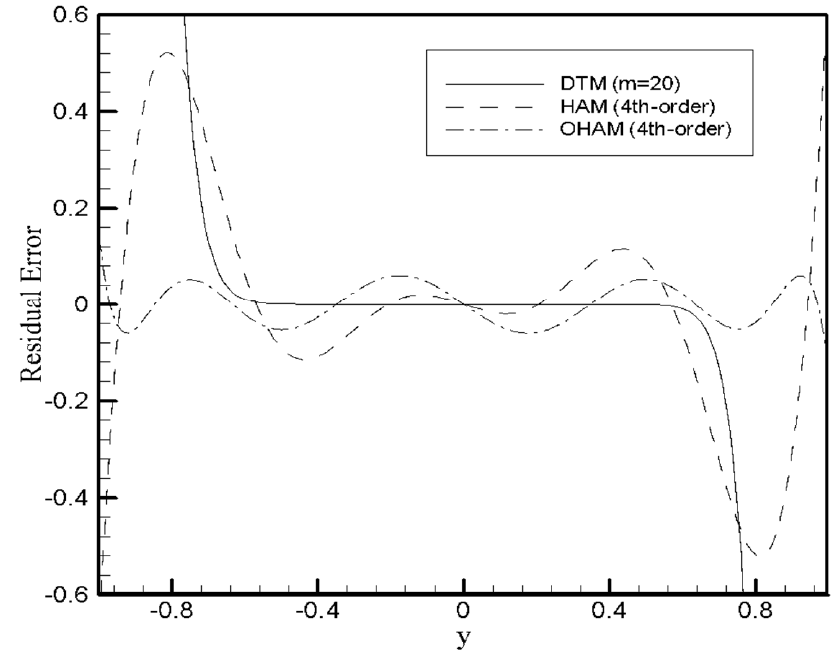
Figure 6. Residual error of different approaches for the case of Re = 5 and α = 1.